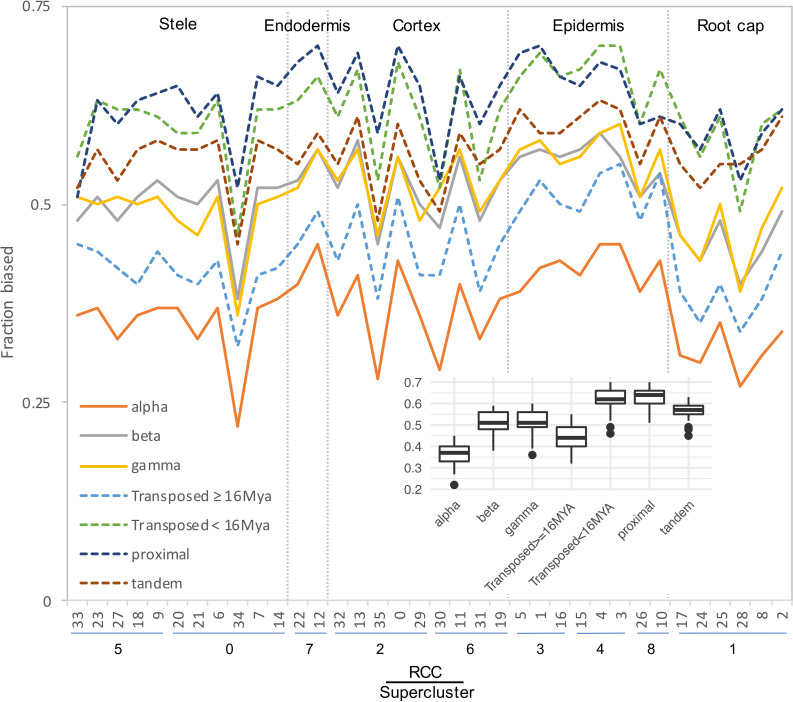
Fraction of gene pairs exhibiting paralog expression bias by RCC. RCCs are arranged by supercluster and ordered roughly from the interior (stele) to the exterior (epidermis) and tip (root cap) of the root. Each line indicates the fraction of gene pairs from the specified duplication mechanism that exhibit expression bias per RCC. For ease of comparison, whole genome duplications are shown with solid lines, and small scale duplications are shown with dashed lines. Individual gene pair by RCC combinations that lacked sufficient read depth to detect bias were excluded from the analysis. Inset, box plot summarizing the distribution of bias fractions by duplication type.